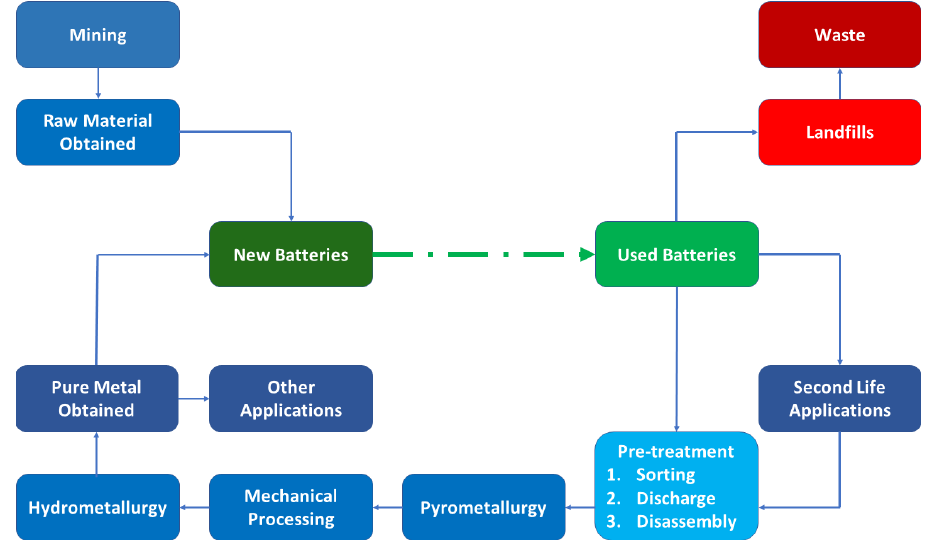
Figure 4. Lithium-ion battery recycling process.